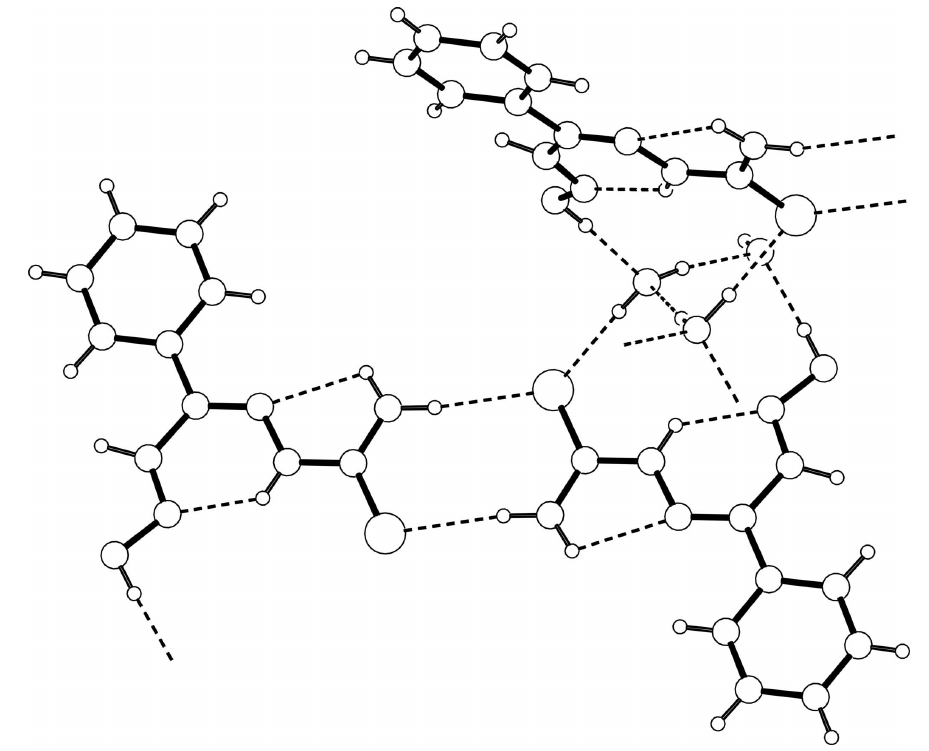
Figure 2 A part of the crystal structure of (I), showing the formation of R 22 (8) and R 41 (11) ring motifs. Hydrogen bonds are shown as dashed lines.